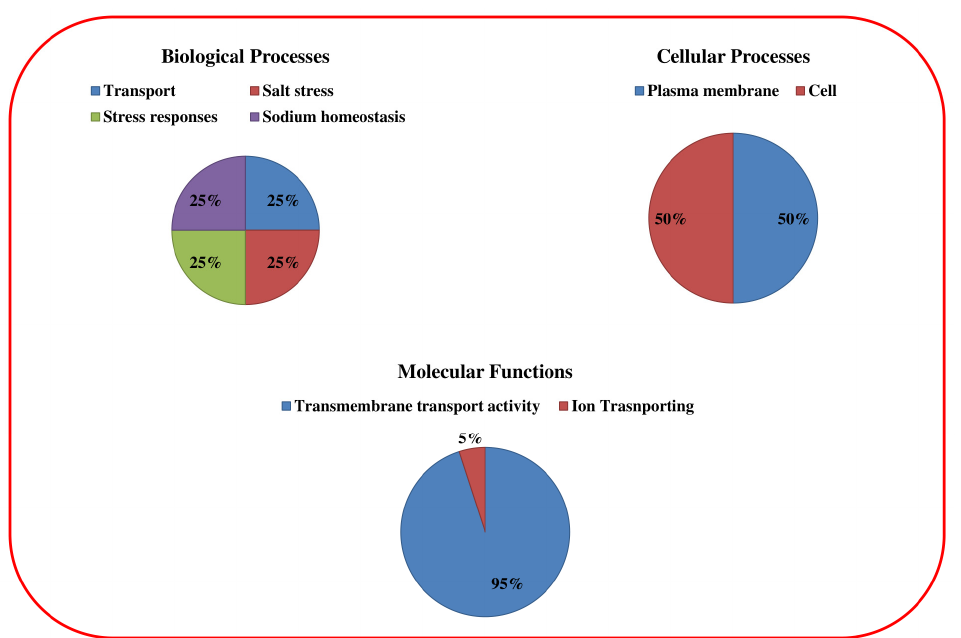
Figure 4. Gene ontology of the OsHKT gene family in rice. The figure displays the predicted biological, molecular, and cellular functions of OsHKT genes.